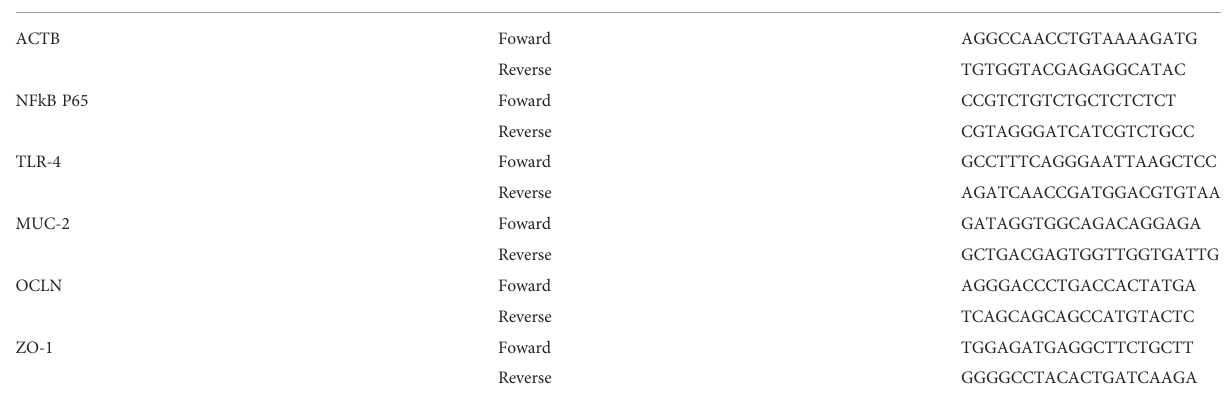
TABLE 1 Gene sequence forward and reverse (ACTB, NFKB-P65, TLR-4, MUC-2, OCLN, ZOI).